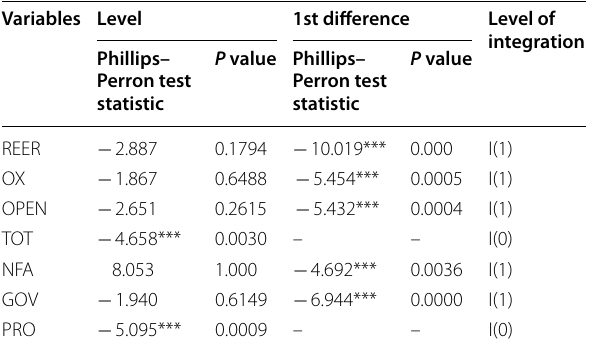
***Significance at the 1% levels